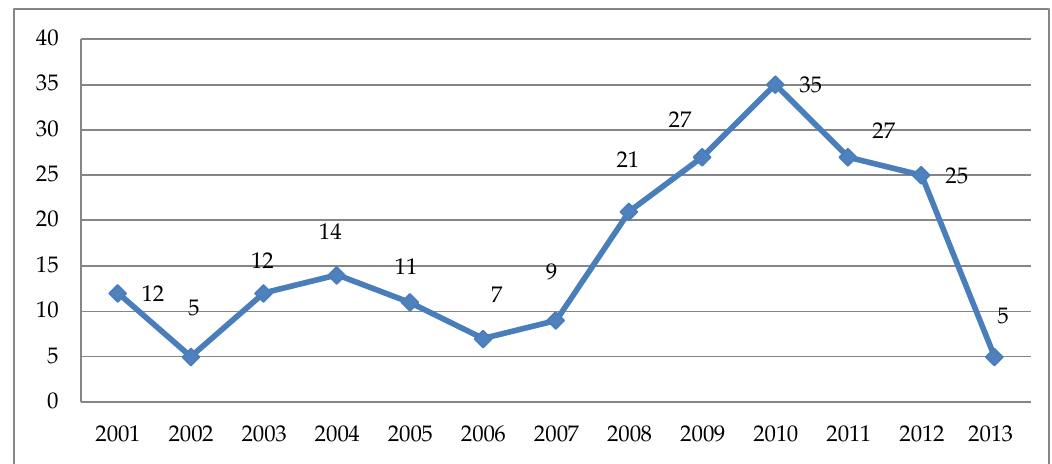
Figure 2. Occupational diseases / work-related disorders ( n = 210) diagnosed among migrant workers assessed from January 2001 to June 2013. Table 2. Main types of occupational diseases / work-related disorders diagnosed among the assessed migrant workers.